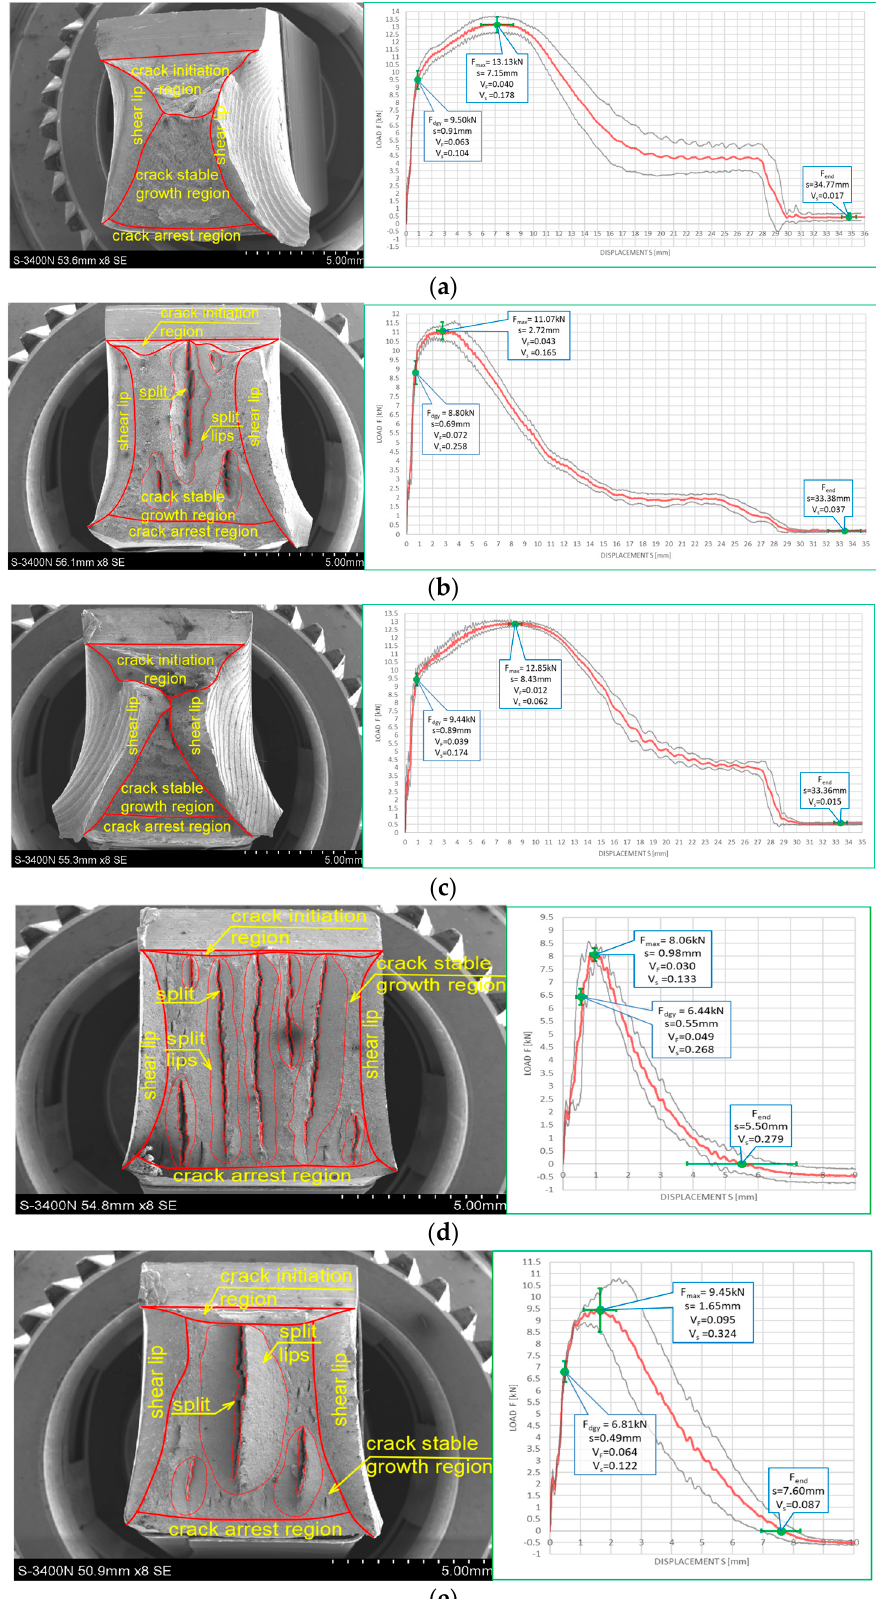
Figure 22. Morphology of the impact fractures obtained during the tests conducted at +20 °C on the samples made of X2CrNiMoN22-5-3 steel—denotations follow the key listed in Table 1. ( a ) 4 (+20) ; ( b ) 460 (+20) ; ( c ) 461 (+20) ; ( d ) 480 (+20) ; ( e ) 481 (+20) .